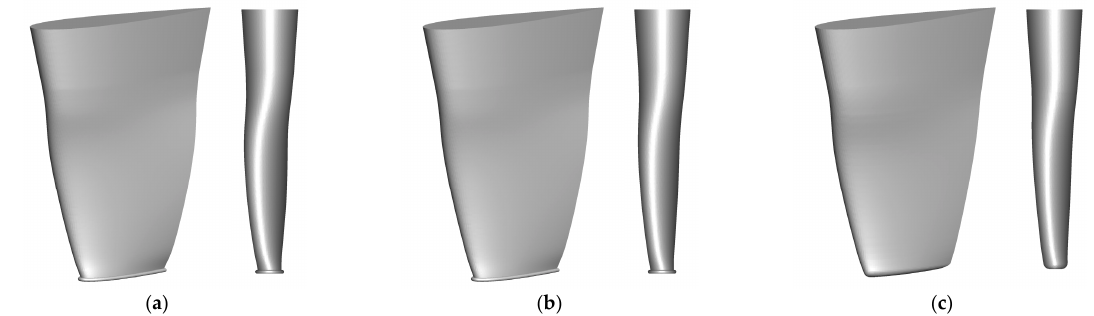
Figure 13. Designed twisted rudders: ( a ) TR-ini; ( b ) TR-int; ( c ) TR-fin.